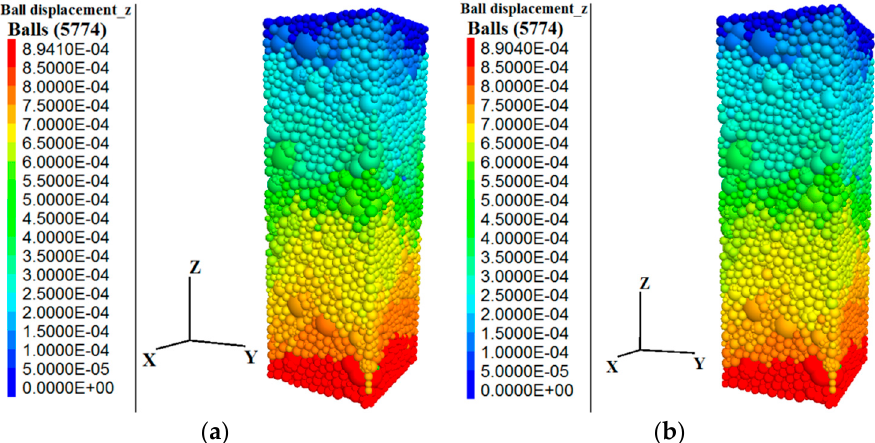
Figure 9. Axial displacement of concrete particles under ( a ) 75 and ( b ) 150 freezing–thawing cycles.